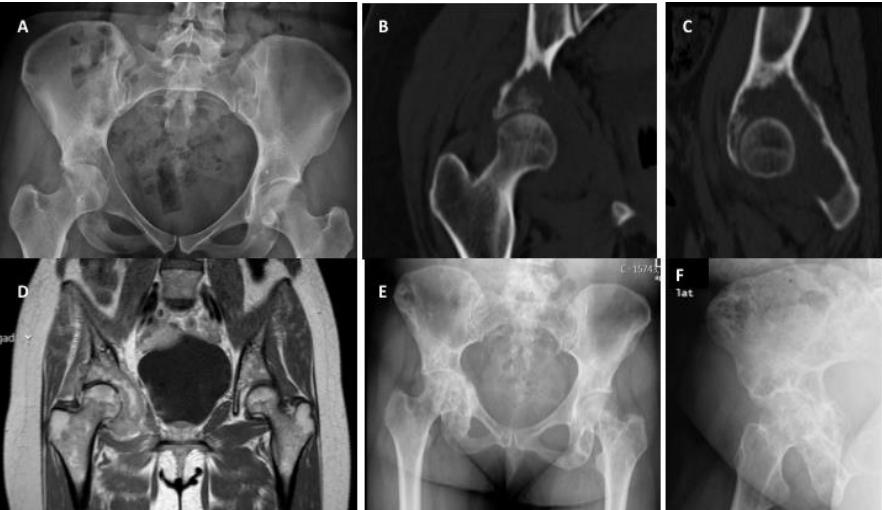
Figure 2. Right acetabular impending fracture in a female patient with breast cancer and multimetastatic bone disease: ( A ) anteroposterior pelvic radiograph showing a lytic lesion located in the right acetabulum, ( B ) pelvic coronal computed tomography showing in more detail the lytic bone metastasis on the right acetabulum, visible in plain radiograph, ( C ) sagittal computed tomography showing a detailed characterization of the lytic bone metastasis on the right acetabulum, ( D ) magnetic resonance coronal image showing the extension of breast cancer metastasis, occupying the right acetabulum, ( E ) pelvic anteroposterior radiograph showing an exceptional result three months after radiation and denosumab treatment of the impending fracture in ( A ), ( F ) alar view of the right acetabulum after radiation and denosumab treatment.